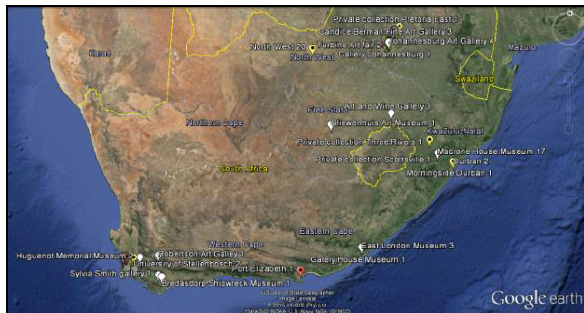
Figure 4: Mapped incidences of heritage crime in South Africa indicating location of crime and number of incidences (© 2015 Google